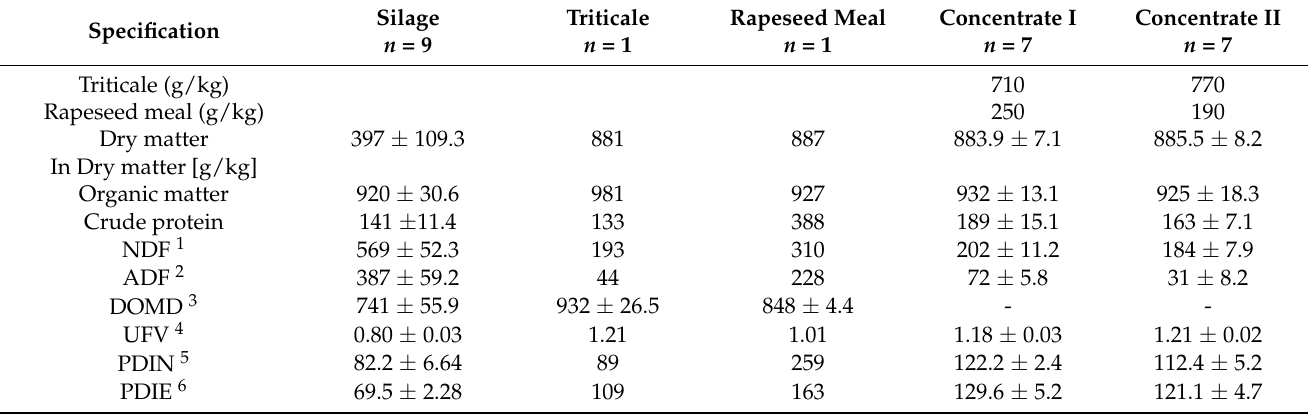
Table 1. Chemical composition and nutritional value of experimental diets (mean ±